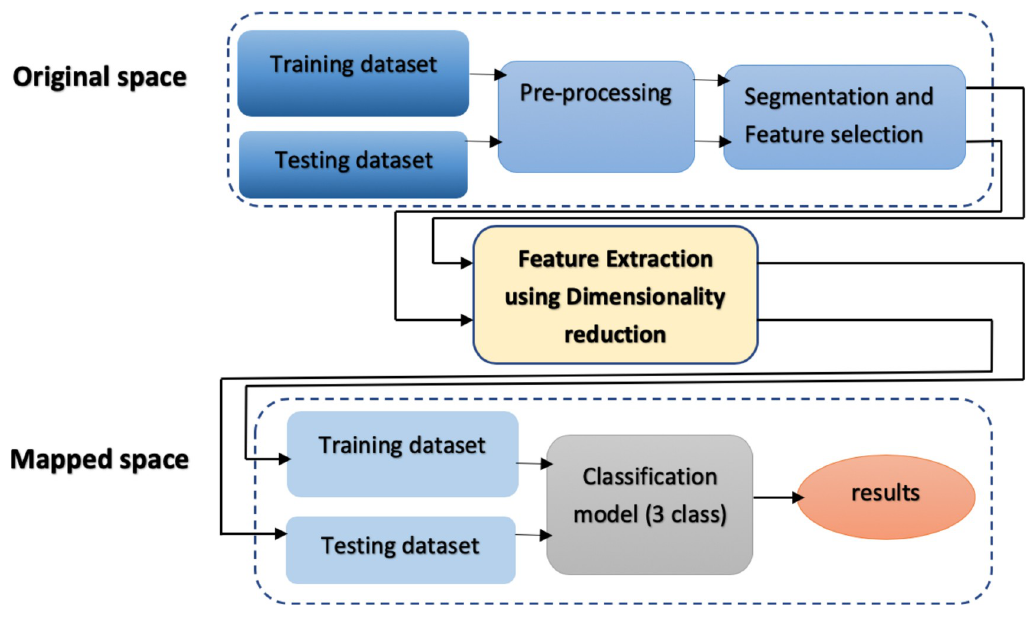
Fig 1. Processing pipeline for EMG signal